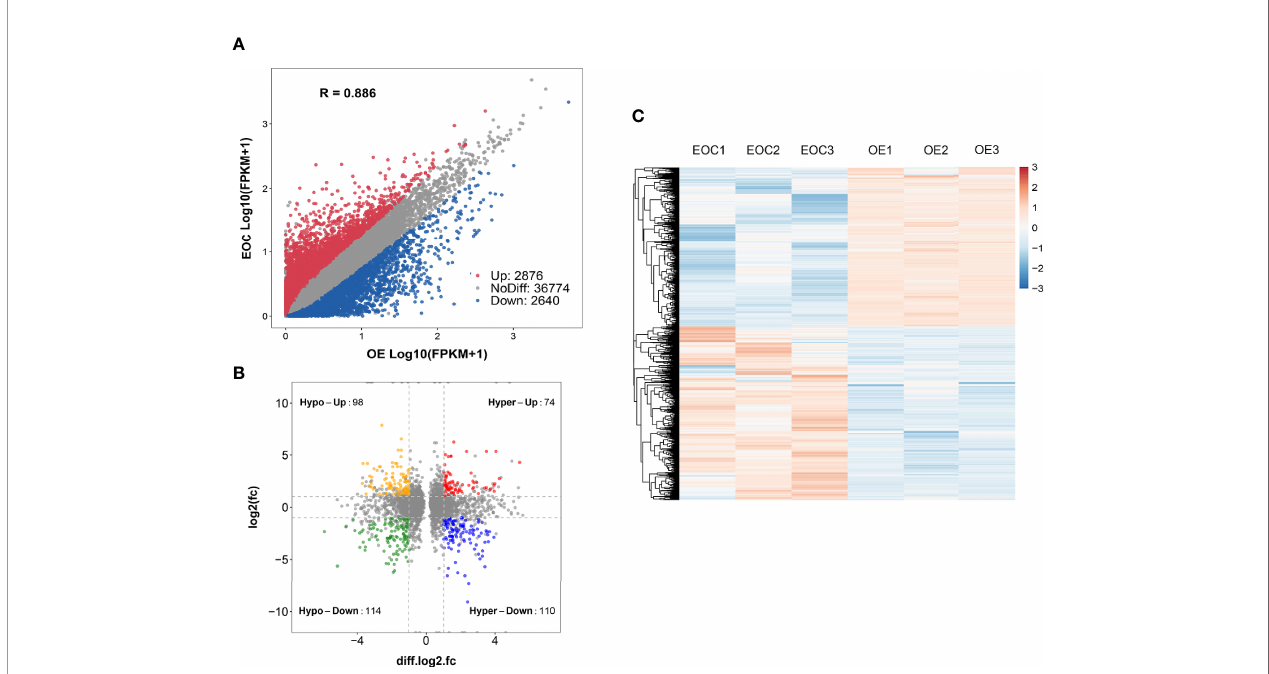
FIGURE 3 | Conjoint analysis of MeRIP-seq and RNA sequencing data. (A) Scatter plot presenting the differentially expressed genes in EOC. (B) Four-quadrant plots presenting the distribution of genes with signi fi cant alterations in both the m6A modi fi cation and mRNA levels. (C) Heatmap plots exhibiting the differentially expressed genes of EOC and OE